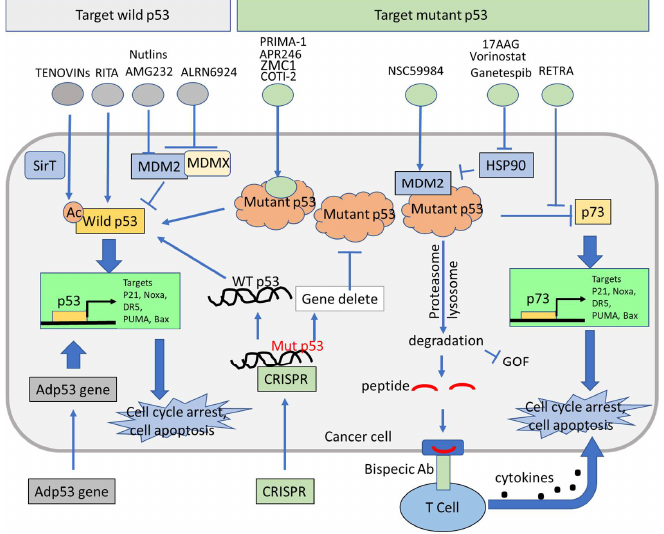
Figure 2. Strategies for targeting mutant p53 and wild-type p53 in cancer cells. Pharmacological approaches for targeting wild-type and mutant p53 in cancer cells are focused on small molecules (upper panel). Small molecules targeting wild-type p53 activation via binding to p53 (such as RITA), inhibition of MDM2/X (such as an MDM2 inhibitor nutlin-3 and the dual inhibitor ALRN6924), post-translational modifications (such as tenovin). Small molecules target mutant p53 via restoration of p53 function (such as PRIMA-1), degradation of mutant p53 via activation of MDM2 (such as 17AAG and NSC59984) or interruption of mutant p53-p73 interaction (such as RETRA). Activation of p73 upregulates p53 target gene expression and induces cell death. Biotherapeutic approaches are based on gene transfection and genomic modifications (bottom panel). p53 is transfected into cancer cells with an adenovirus to replace mutant p53, and upregulates p53 signaling (such as rADp53). Genomic editing is used to restore wild-type p53 or delete mutant p53 in cancer cells by genome editing approaches (such as CRISPR). A bispecific antibody with mutant p53-specific peptide and ALH ligands promotes T cells to recognize and kill p53-mutant tumor cells in cancer immunotherapy.